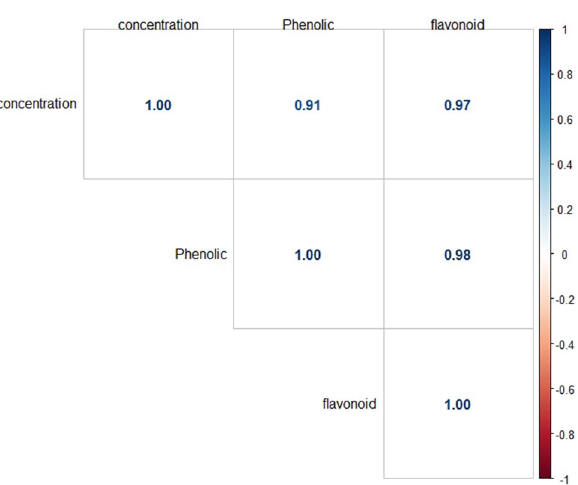
Figure 1. Correlation matrix showing the concentration of the crude polyphenolic extract (CPE) with total phenolic and flavonoid contents.